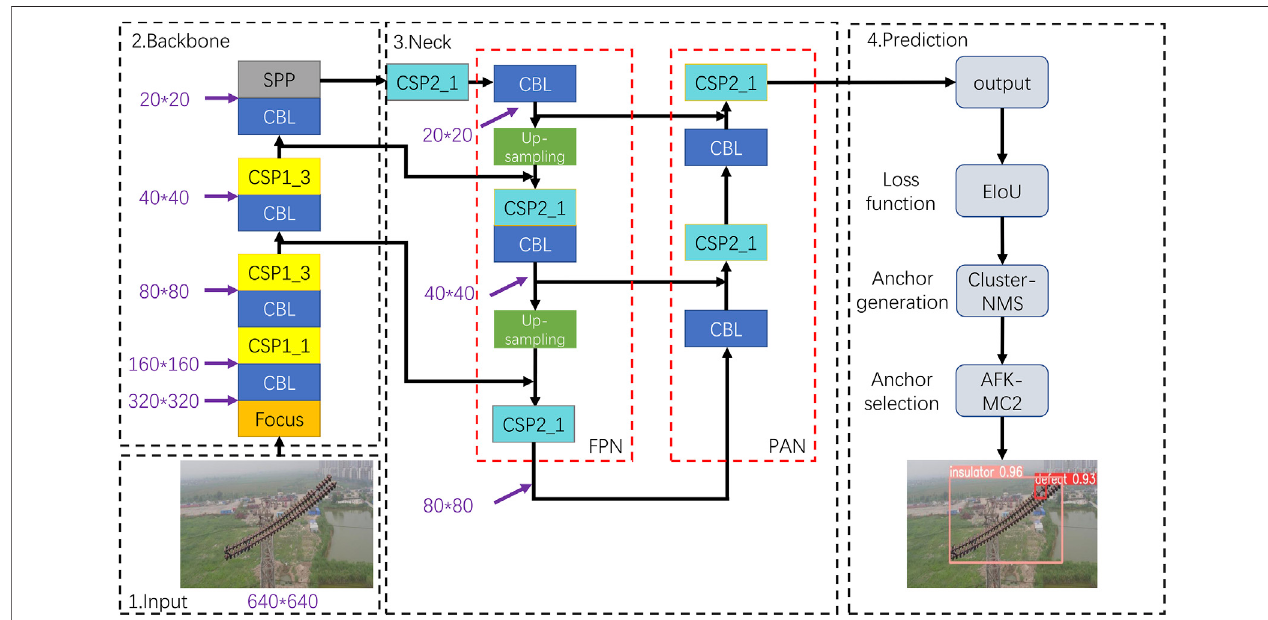
FIGURE 2 | Entire model structure:1) Input an insulator image. 2) Backbone to extract feature map. 3) Neck to process the feature map and dig the deeper information. 4) Prediction to detect the insulator and